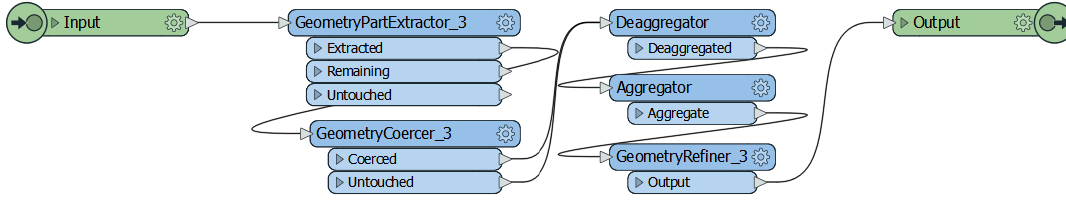
Figure 16. “ConvertGeometry” custom transformer workflow.